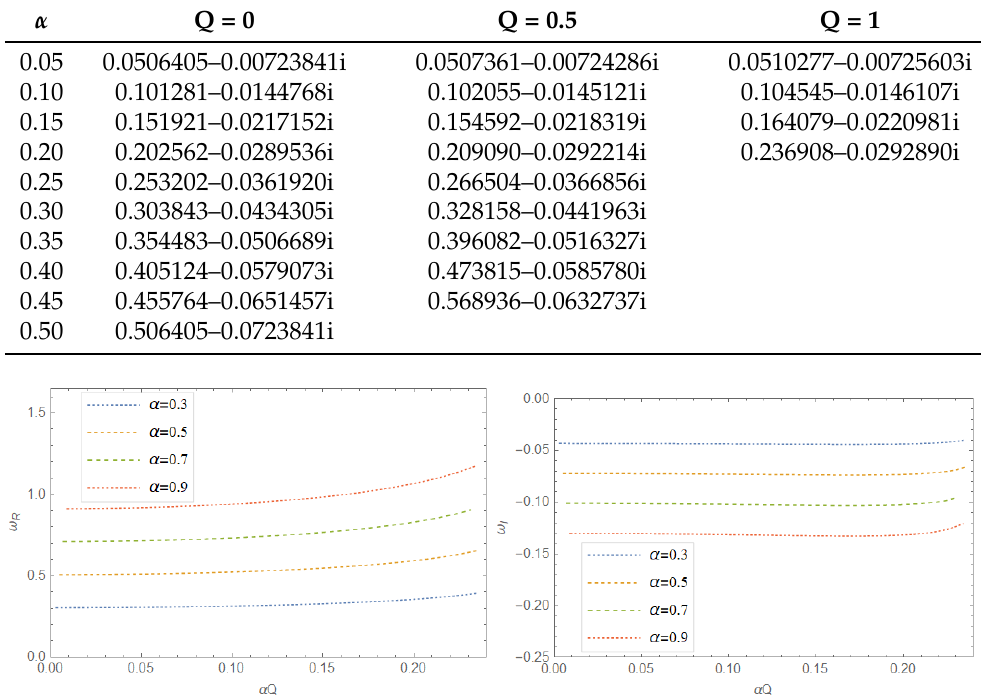
Table 1. The eigenfrequencies of QNMs for different values of the parameters α and Q .